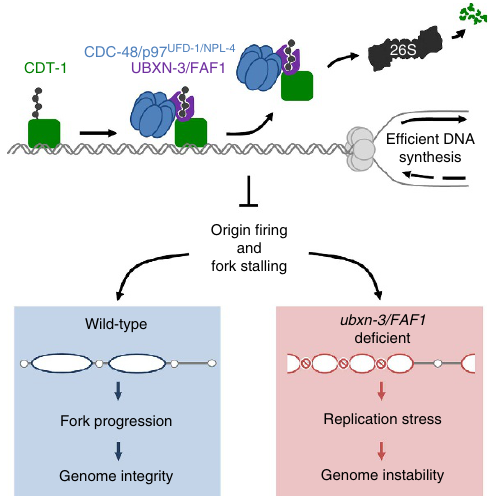
Figure 7 | UBXN-3/FAF1 defines chromatin-associated degradation to assure DNA replication fork progression. Hypothetical model for the role of UBXN-3/FAF1 in CDC-48/p97-regulated DNA replication. UBXN-3/FAF1 (purple) binds ubiquitylated CDT-1 (green) bound to the chromatin and recruits the CDC-48/p97 UFD-1/NPL-4 complex (blue) for disassembly and subsequent turnover of the replication factor by the 26S proteasome. Regulation of chromatin-associated CDT-1 is vital to assure efficient DNA synthesis, protecting cells from DNA replication